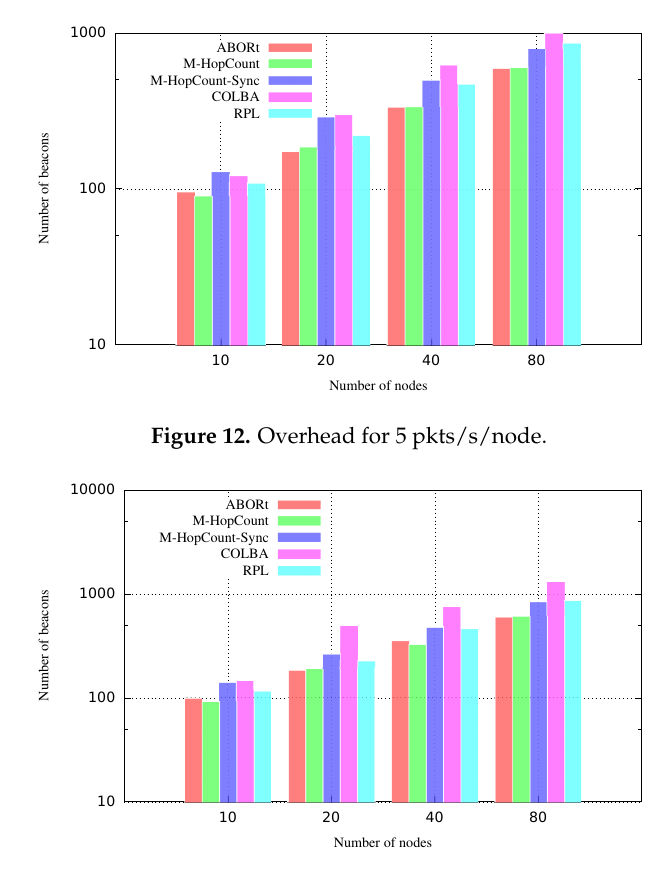
Figure 13. Overhead for 10